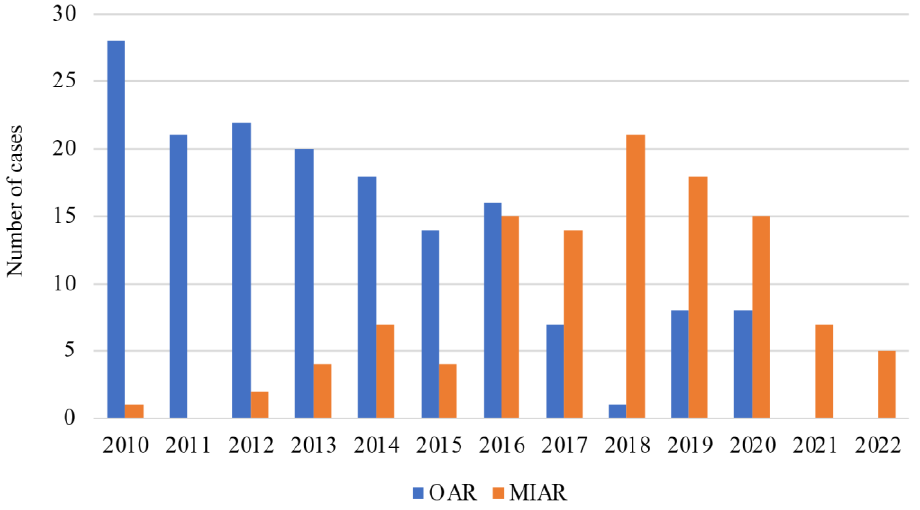
Figure 4. Annual number of cases undergoing OAR (blue bars) and MIAR (orange bars) for newly developed HCC.